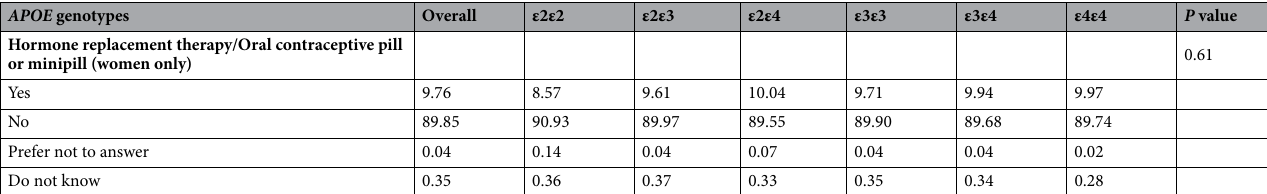
Table 1. Characteristics of the participants by common APOE genotypes in the UK Biobank at baseline. a Townsend deprivation index for each participant was calculated based on the preceding national census output areas in which their postcode is located. b A high activity group was defined as levels of physical activity equates to approximately at least one hour per day or more, of at least moderate-intensity activity above the basal level of physical activity. A moderate activity group was defined as levels of physical activity equates to half an hour of at least moderate-intensity physical activities on most days. A low activity group was defined as levels of physical activity not meeting any of the criteria for either of the high or moderate activity